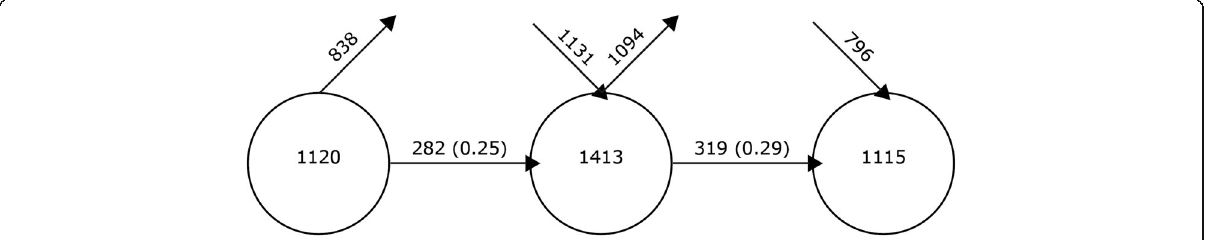
Fig. 4 Keyword continuity between contiguous